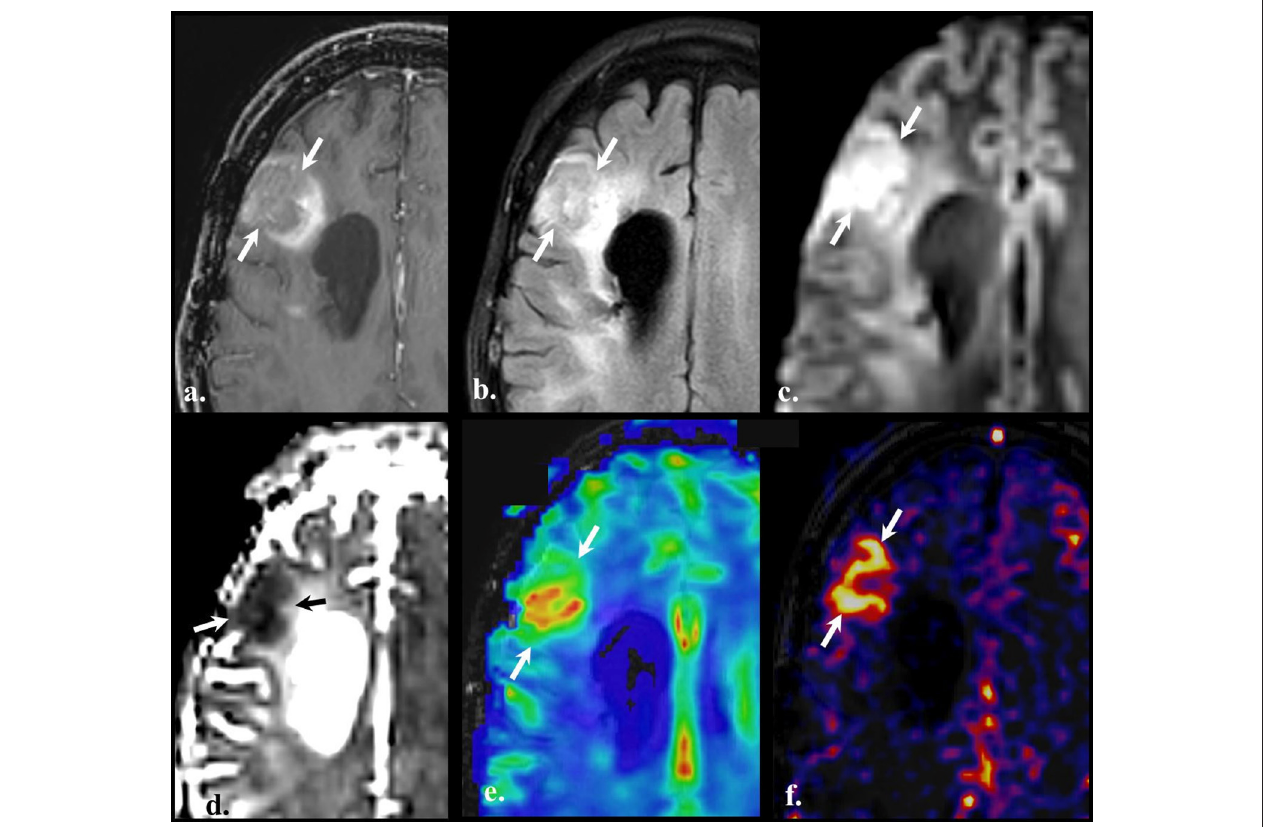
FIGURE 5 | Perfusion-weighted imaging (PWI). Brain MRI of a old with a diagnosis of recurrent GBM (IDH wild-type, MGMT status unknown) on bevacizumab treatment. Axial contrast-enhanced T1w (a) , FLAIR (b) , DWI (c) , ADC (d) , Dynamic susceptibility contrast (DSC) (e) , and Pseudo-continuous arterial spin labeling (f) . Compared with the baseline scan, an evolving non-enhancing FLAIR hyperintense lesion (arrows on a and b ) is noted on the right frontal lobe in the vicinity of the surgical cavity (not shown). The lesion shows high signal on DWI (arrows on c ) with the reciprocal dark appearance on ADC map (arrows on d ) due to hypercellularity. Dynamic susceptibility contrast depicts increased cerebral blood volume (CBV) (arrows on panel e), and pseudo-continuous arterial spin labeling (pCASL) reveals an increment in the cerebral blood flow in the same location. PWI findings are indicative of vascular proliferation.